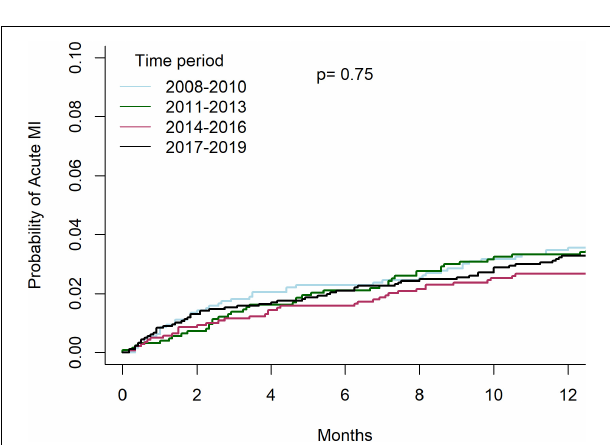
FIGURE 8 | Cumulative incidence of acute-MI at 1 year, grouped by time period.